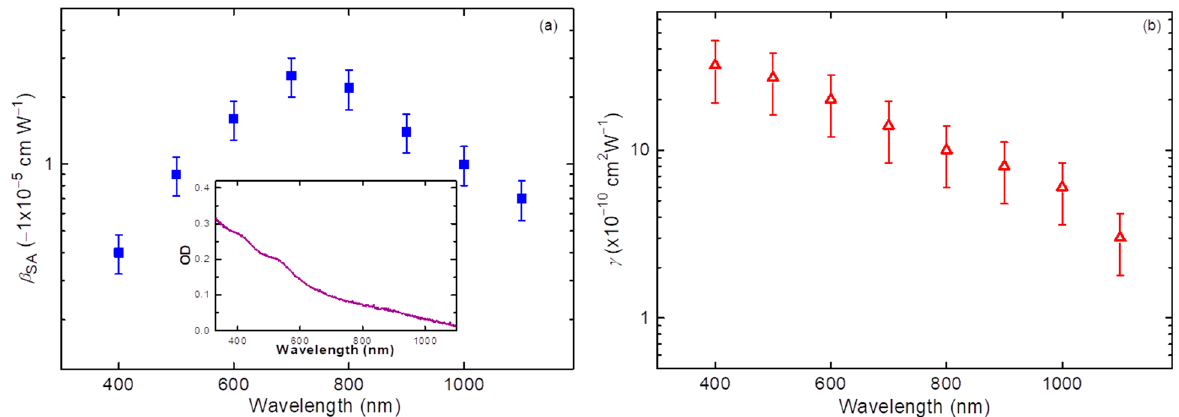
Figure 3. Spectral dependences of the negative nonlinear absorption attributed to SA ( a ) and the negative nonlinear refraction ( b ) of the MTQD film measured by 28 ps probe pulses. Inset in ( a ): optical density (OD) of the film in the studied spectral region. Our film was characterized by steady growth of absorbance toward shorter wavelengths.